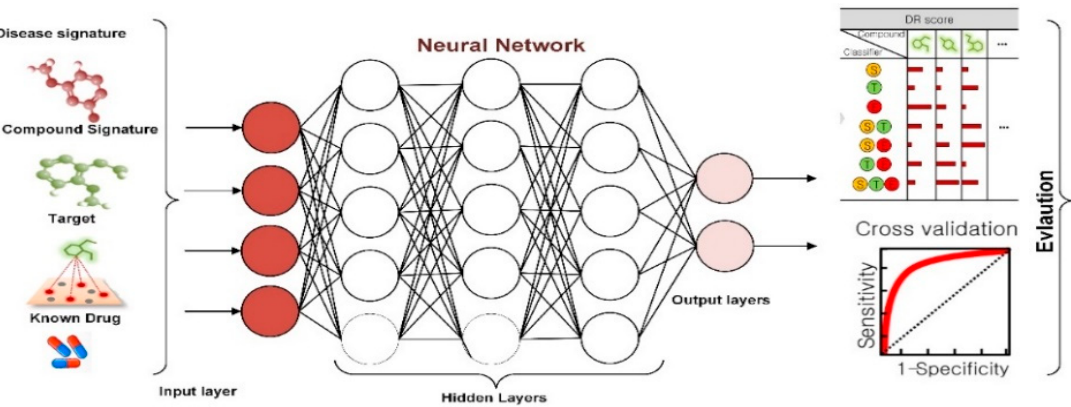
Figure 3. Drug repurposing based on AI techniques.